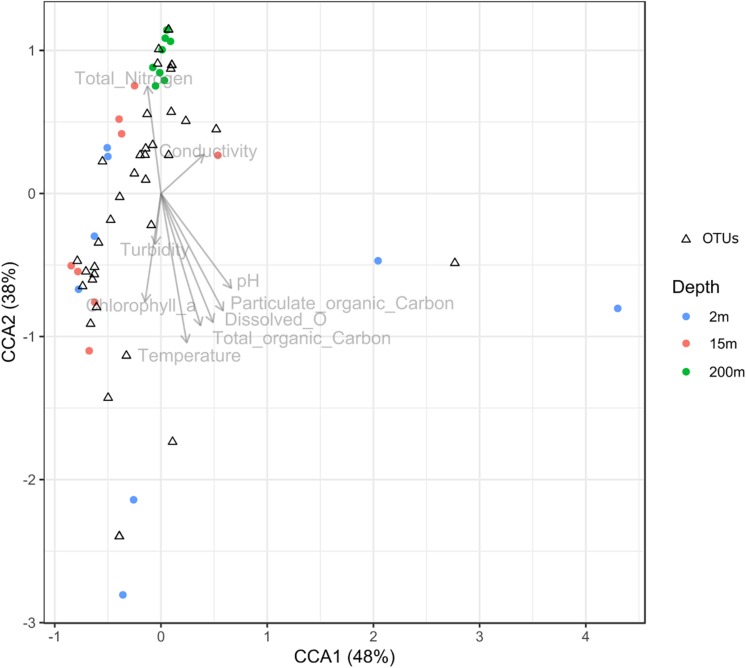
Canonical correspondence analysis (CCA) diagram showing the ordination of OTUs along the first two axes and their correlation with environmental variables.